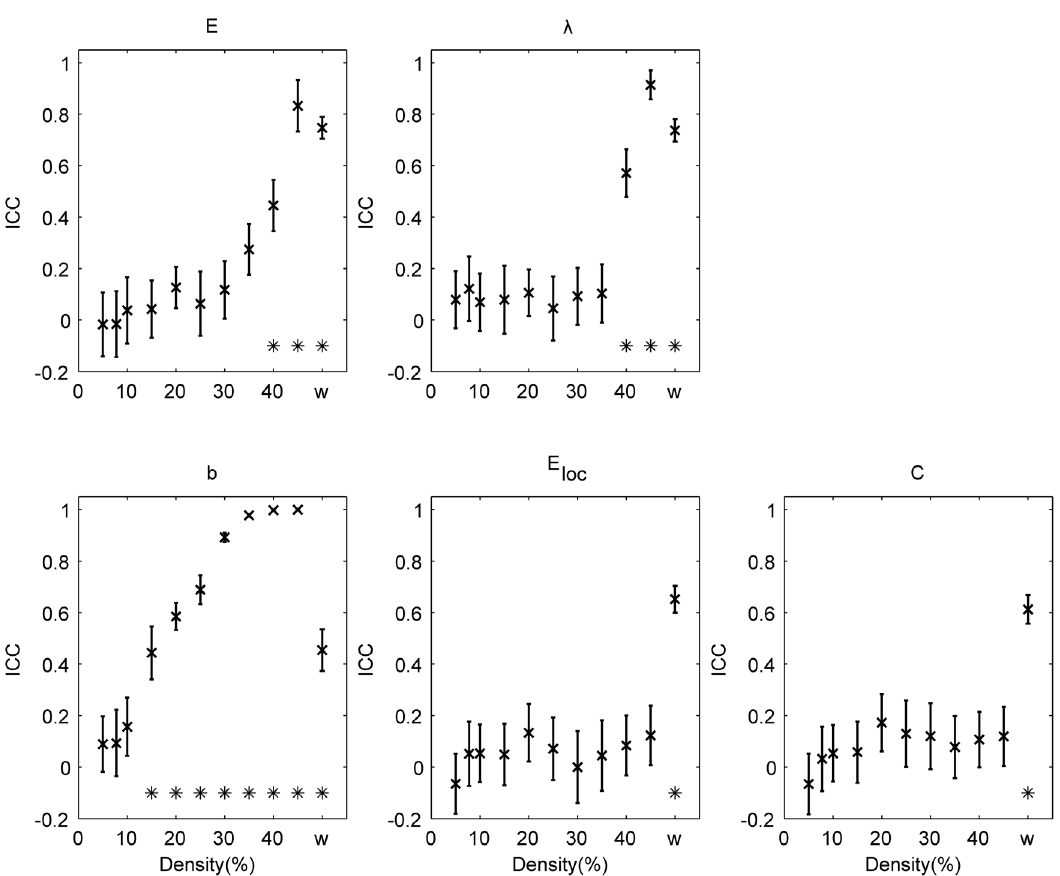
Fig. 1. Reproducibility at the individual level. ICC for the global efficiency ( E ), the characteristic path length ( l ), the mean betweenness centrality ( b ), the mean local efficiency ( E loc ) and the mean clustering coefficient ( C ). The results are shown for binary (over a range of densities) and weighted (w) networks. Error bars denote the standard deviation. Values significantly ( p cor v 0 : 05 ) higher than 0 : 4 are indicated with